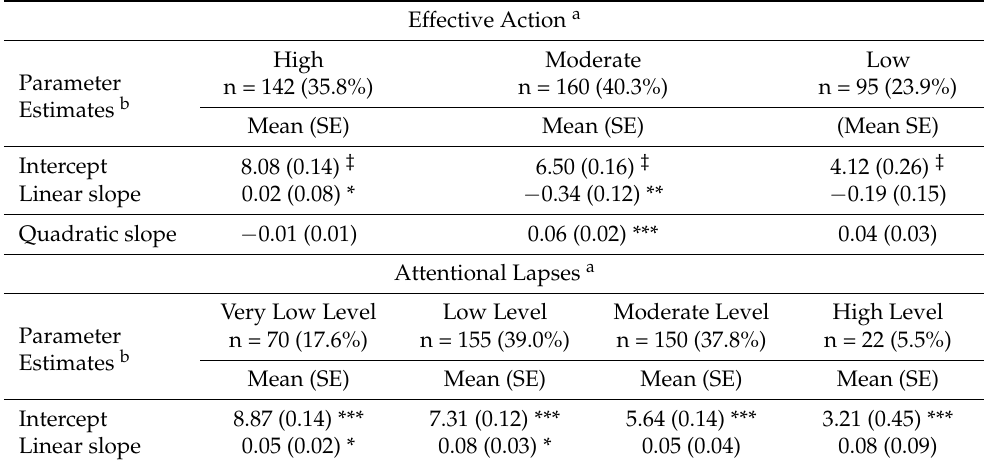
Table 3. LCGA Parameter Estimates for the Latent Class Solutions for the Effective Action, Attentional Lapses, and Interpersonal Effectiveness Subscale